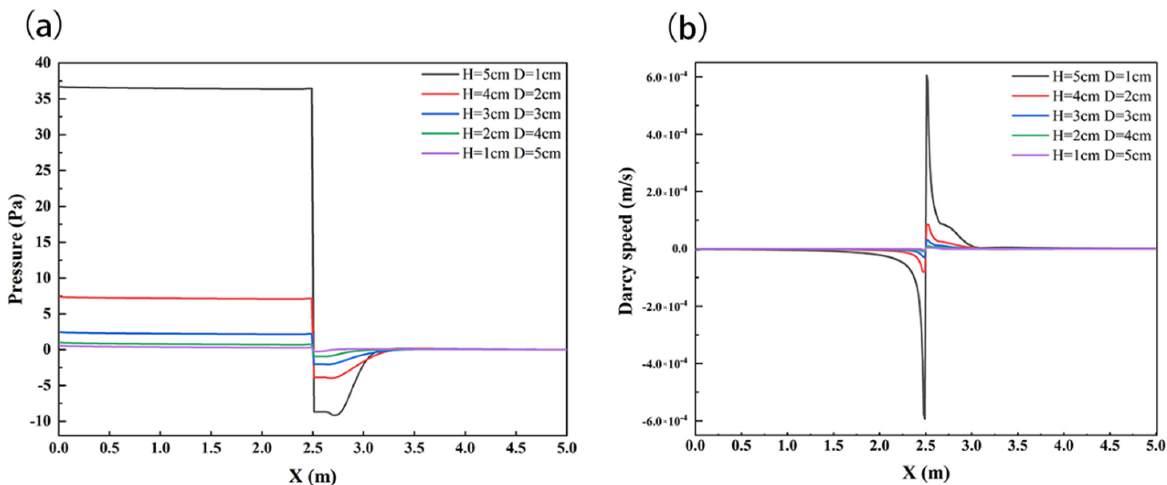
Figure 5. SWI pressure distribution diagram ( a ) and velocity distribution diagram ( b ) under the influence of structural H and D changes. Channel flow is left to right.